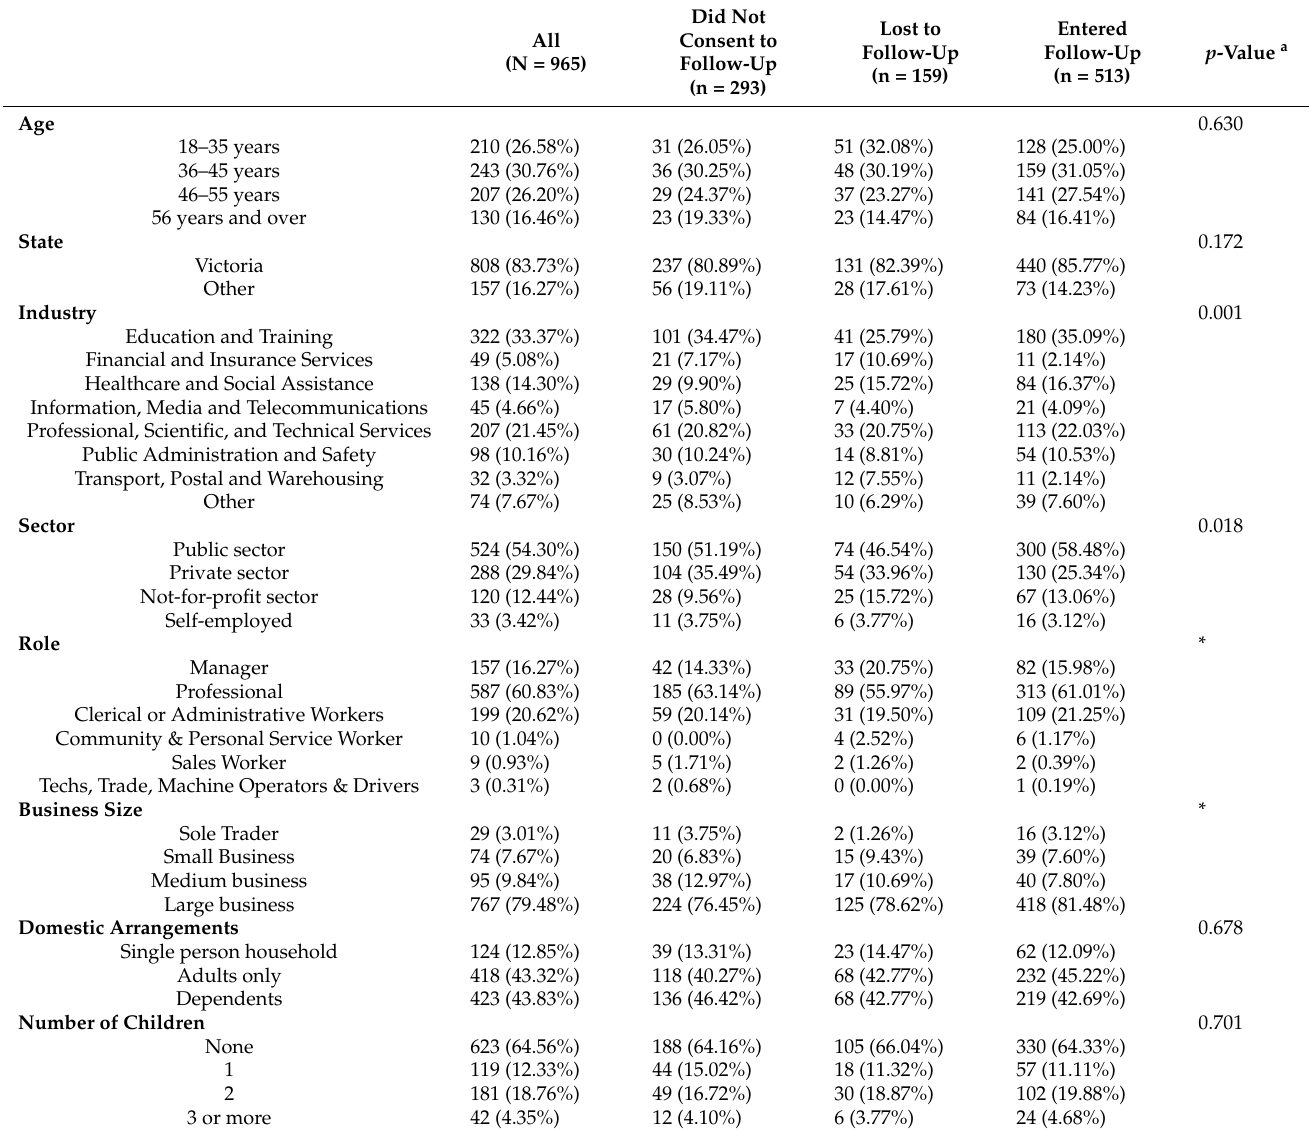
Table 1. Demographic characteristics of baseline participants characteristics according to follow-up